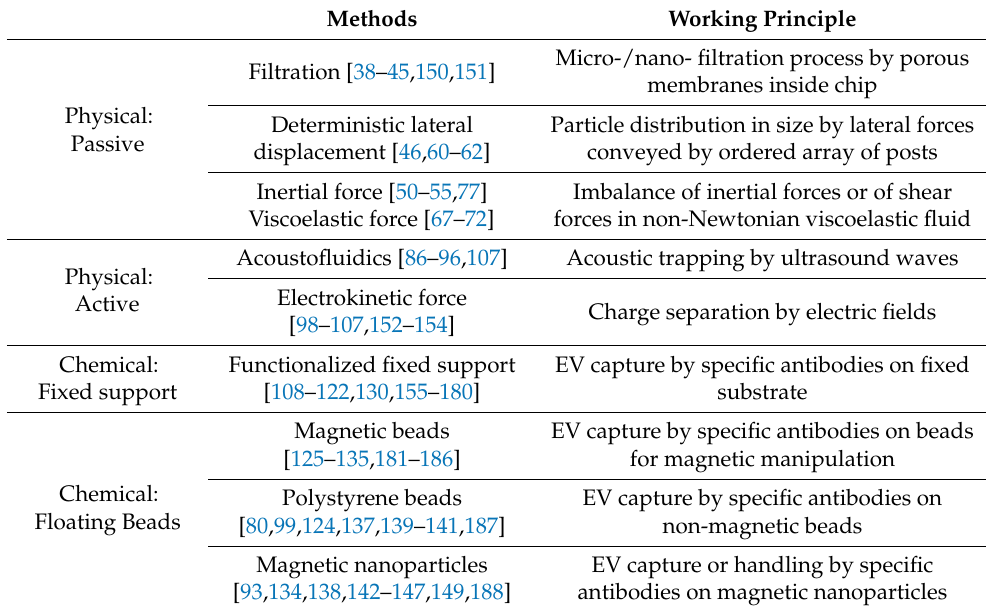
Table 2. Summary of relevant published articles dealing with EV isolation from different microfluidic